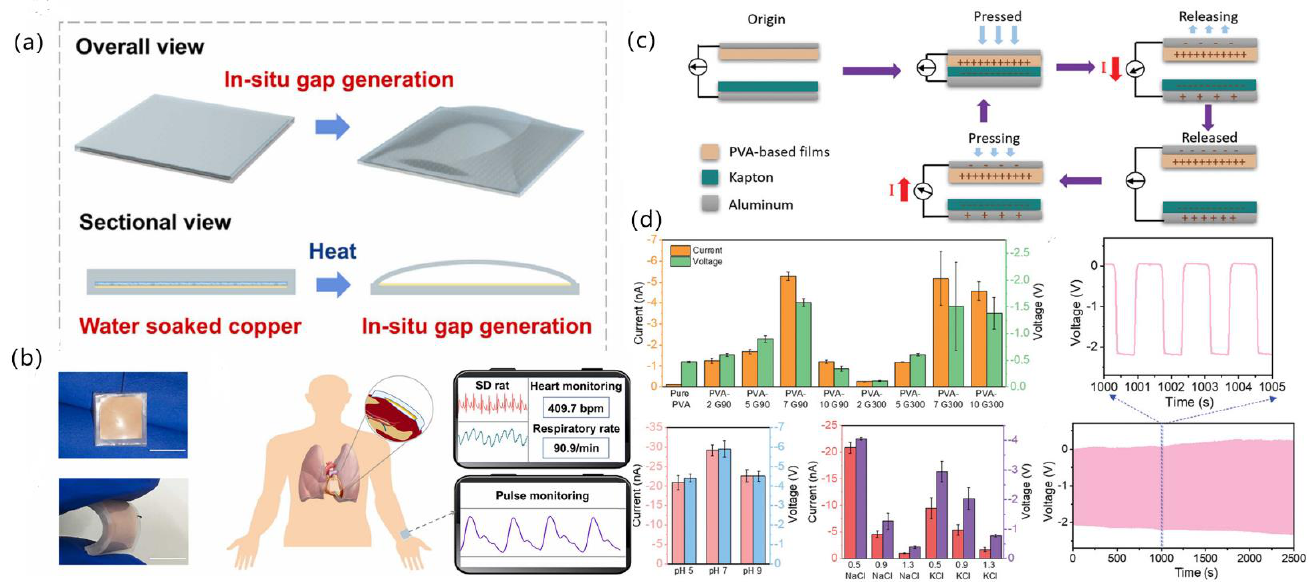
Figure 6. Monitoring cardiovascular information by wearable TENG. ( a ) Schematic diagram briefly showing the in-situ gas gap-generation of the NSTENG [69]; ( b ) Schematic illustration showing the NSTENG to monitor the cardiovascular system [70]; Copyright 2021, Elsevier Ltd. ( c ) Schematic diagram of the working mechanism of PVA-based TENG [71]; ( d ) Summarized currents and volt- ages outputs of PVA-based TENGs, the stability test of PVA−7G90 sample and the enlarged plot corresponding to the time period indicated as the blue dashed box [71]; Copyright 2020, Wiley-VCH.